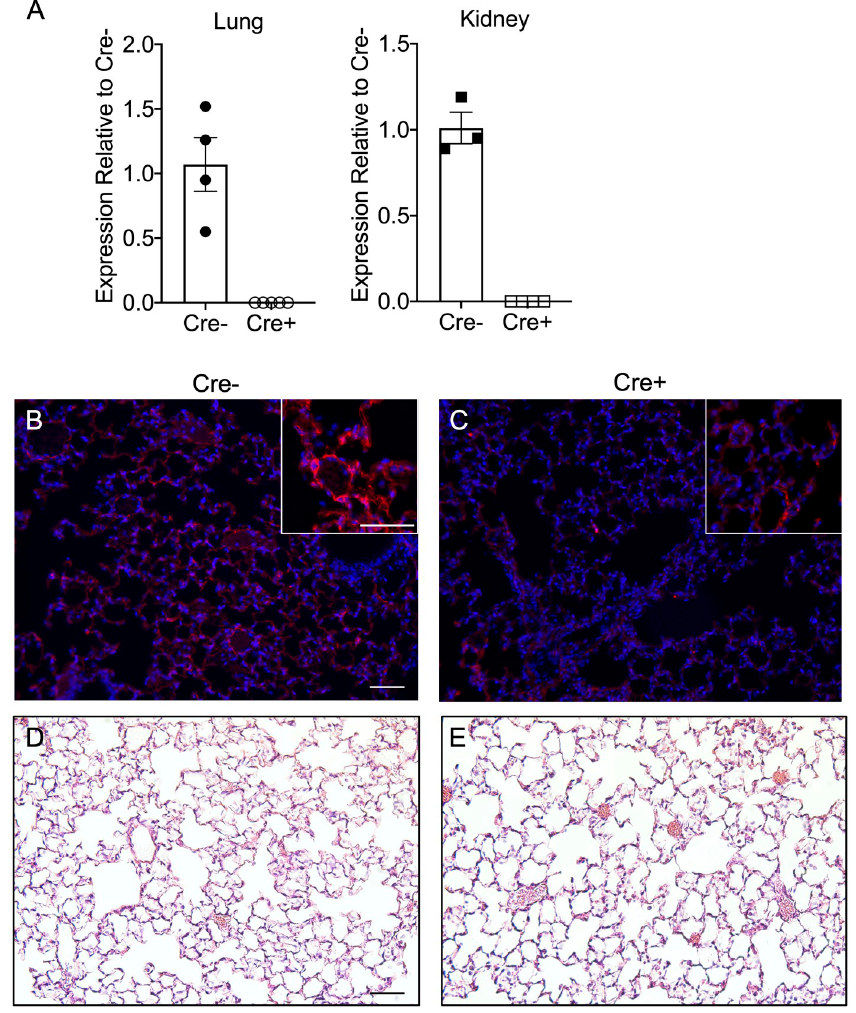
Fig 1. Efficient knockdown of NPNT expression in ROSA-CreER/+;Npnt-Flox/Flox mice after tamoxifen treatment. (A) qPCR analysis of Npnt mRNA levels in lung and kidneys from Cre- and Cre+ mice after 4 weeks on the tamoxifen diet followed by normal chow. Expression is shown relative to Cre-. Shown are the means (bars) ± SE. Immunofluorescence staining for NPNT (red) in Cre- (B) and Cre+ (C) lungs from mice fed a tamoxifen diet for 4 weeks followed by chow. Nuclei were stained with DAPI. The insets show the localization of NPNT in Cre- and reduced staining in Cre+ lung tissue. Representative hematoxylin and eosin staining of sections of lung from uninjured Cre- (D) and Cre+ (E) using the same time course of dietary treatment. Scale bar = 50 μ m for all images. for 3–4 weeks, we assessed NPNT protein levels in the lungs by immunofluorescence: in Cre- mice, the pattern of NPNT immunoreactivity is consistent with localization to the basal lami- nae in the small airways (Fig 1B), as was shown in the developing mouse lung [4]. NPNT was also prominent in the alveoli (Fig 1B). Cre+ lungs showed substantial diminution of the signal for NPNT, although isolated areas of staining were still evident (Fig 1C). Deletion of NPNT did not overtly affect lung morphology in Cre+ mice as compared to Cre- at baseline (Fig 1D and 1E); we assessed lung structure quantitatively by measuring the mean linear intercept and found that these values were not different between the genotypes (average of 49.89 μ m ± 4.17 SE for Cre- and 50.04 μ m ± 1.97 SE for Cre+). There were no deleterious effects of NPNT dele- tion on the health or survival of Cre+ animals.